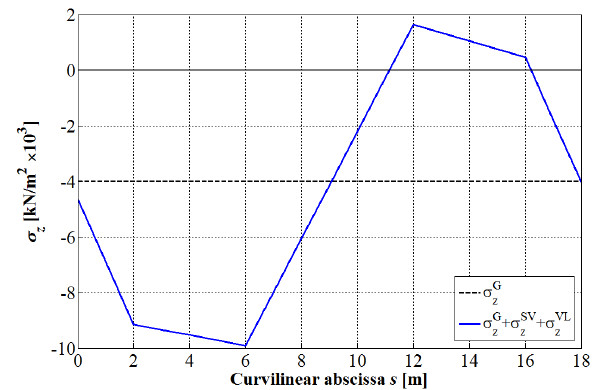
Figure 16: Axial stresses due to horizontal and dead loads acting on open shear wall no. 6.